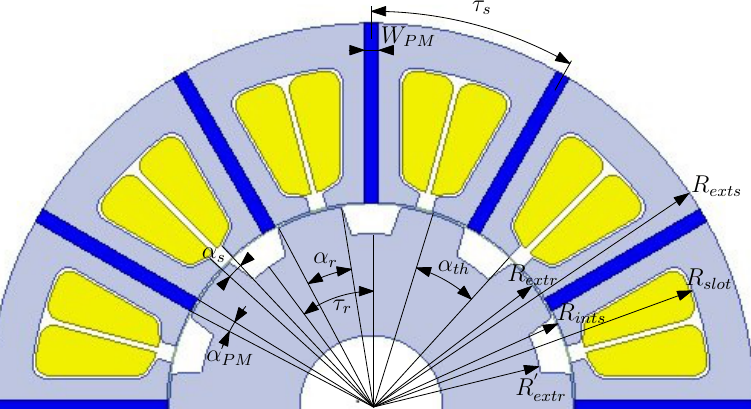
Figure 1. Half of the cross-section of the FSPMM under